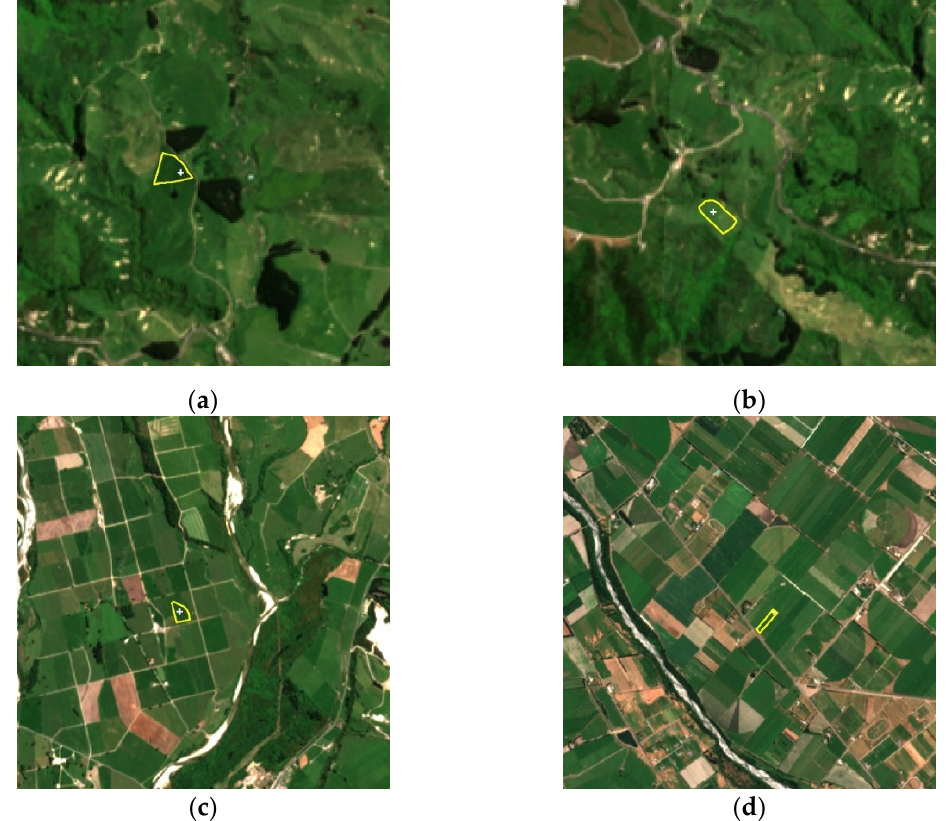
Figure 1. Four examples of sites with measured biomass (white), with hand-drawn polygonal field boundaries (yellow). These are sites with IDs ( a ) 3, ( b ) 4, ( c ) 16, and ( d ) 20. These images are true-colour representations of a mosaic of top-of-atmosphere corrected Sentinel-2 data from the 2017/18 summer.